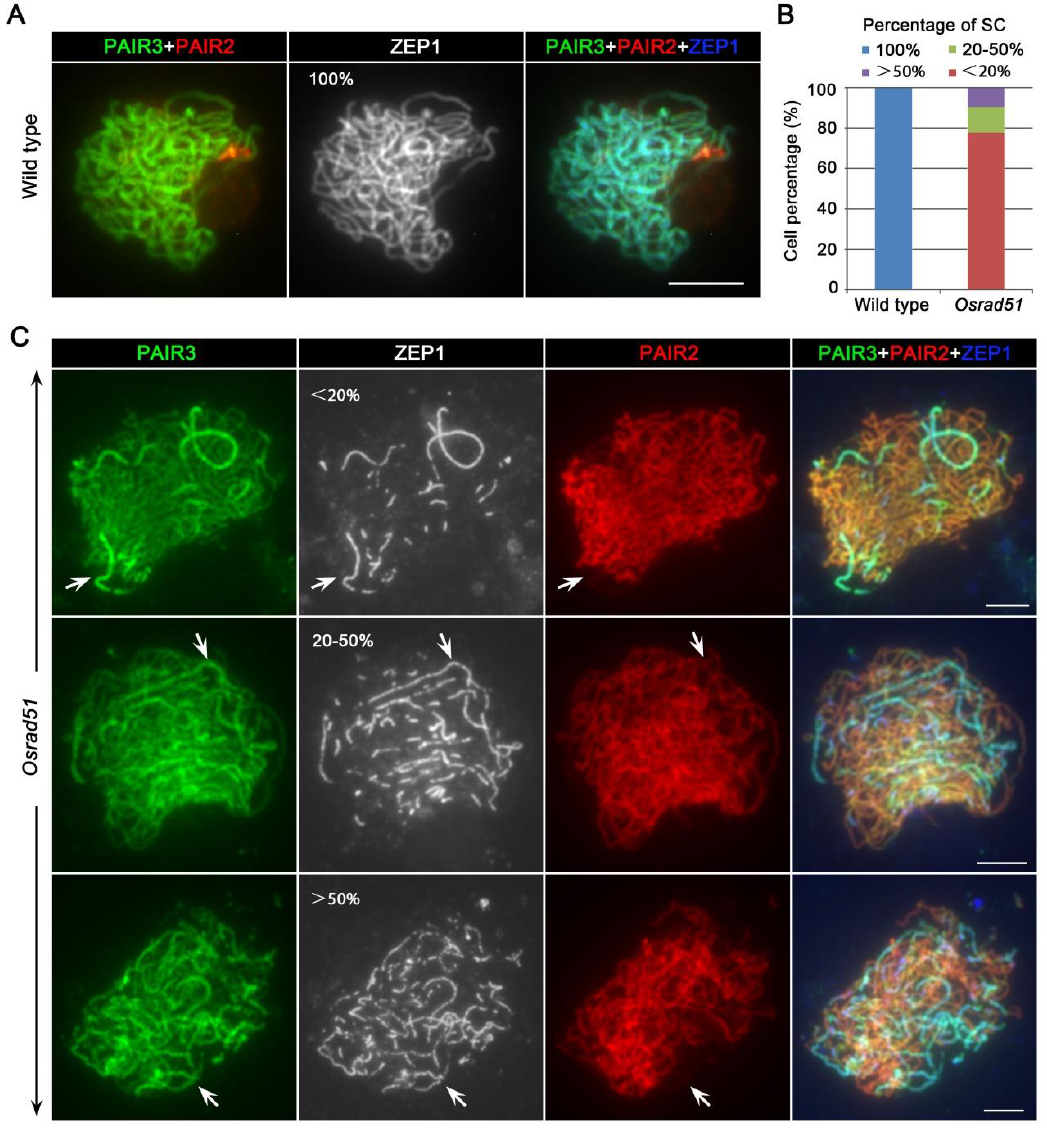
Figure 3. OsRAD51 is required for the full-length homologous synapsis in rice . ( A ). Triple color immunostaining of PAIR2 (red), PAIR3 (green), and ZEP1 (blue) in wild type. ( B ). Histogram of cells according to their proportion of synapsed regions in wild type and Osrad51 . ( C ). Triple color immunostaining of PAIR2 (red), PAIR3 (green), and ZEP1 (blue) in Osrad51 mutant PMCs at pachytene. Arrows indicate the regions where PAIR2 signals disappeared that are exactly where ZEP1 is loaded. Bars, 5 μm.